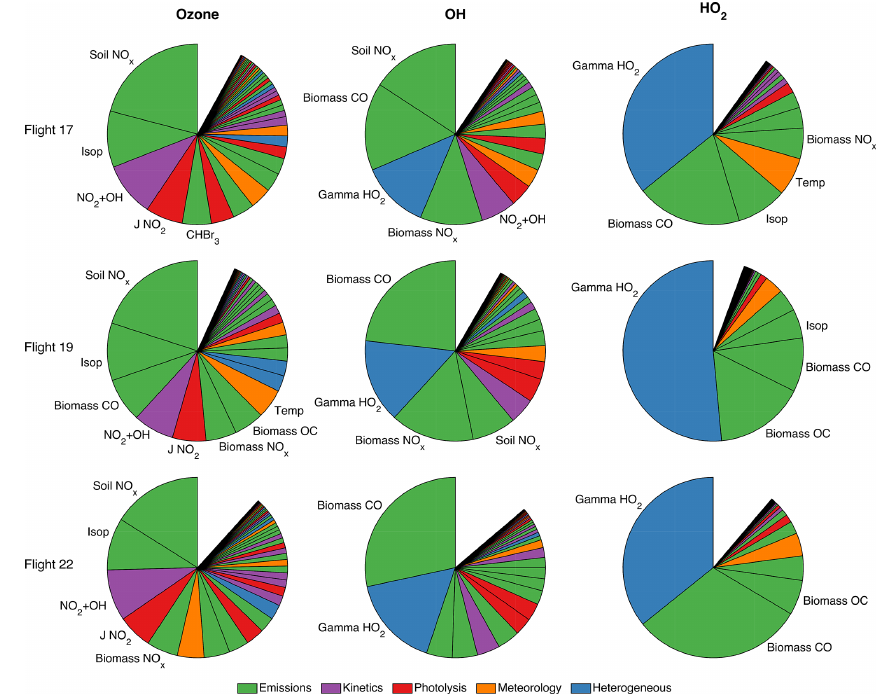
Figure 7. First-order sensitivity indices for average modeled O 3 , OH, and HO 2 along selected ARCTAS-B flights. Legend categories are defined in Table